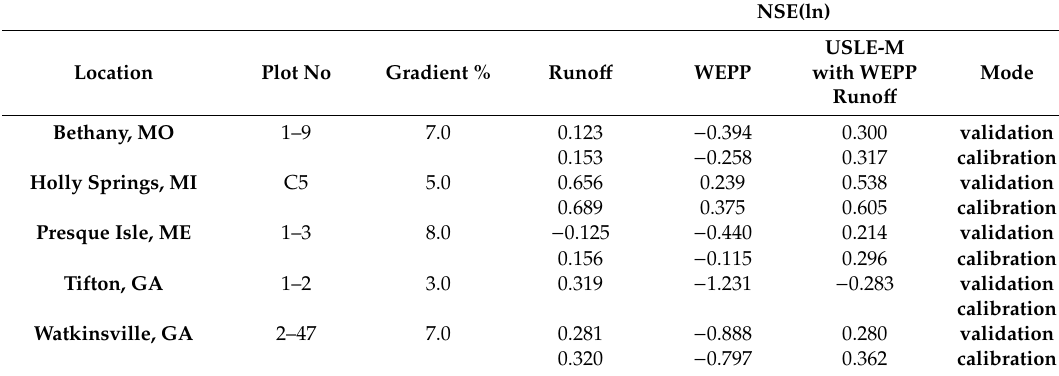
Table 5. NSE(ln) values for WEPP and USLE-M for the prediction of observed event soil losses from 22-m long bare fallow plots in the USLE database when runo ff for both models was predicted by WEPP. NB: WEPP does not predict soil loss to occur for all the storms where soil loss was observed. Calibration for runo ff and soil loss was undertaken using storms where WEPP predicted soil loss did occur, and this ensured that the total runo ff and soil loss for both models matched the total runo ff and soil losses for the events involved (source: Kinnell (under review)